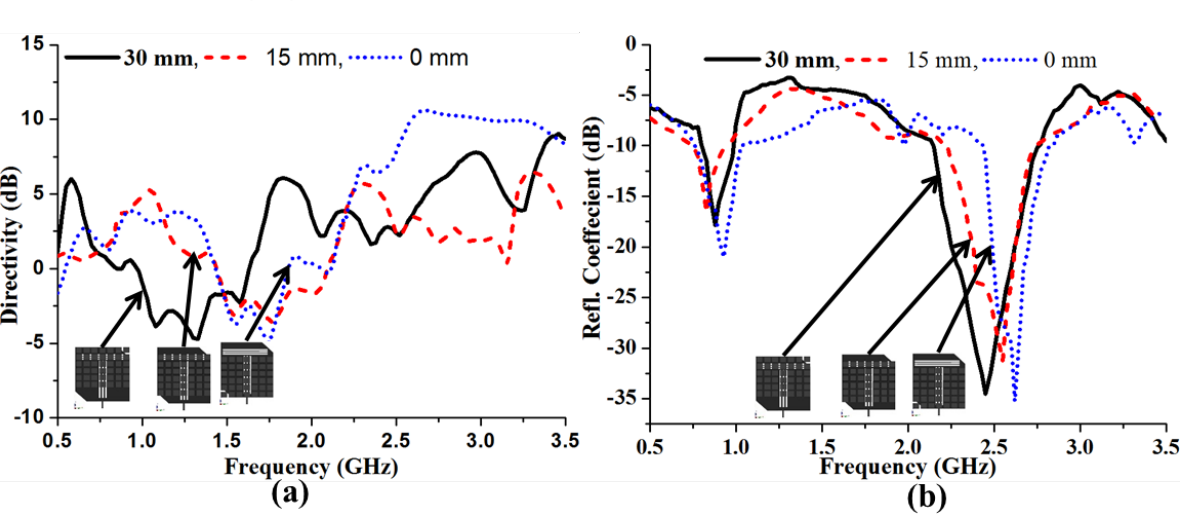
Figure 7. Influence of the MSS position on the directivity ( a ); and ( b ) reflection coefficient of the proposed antenna.